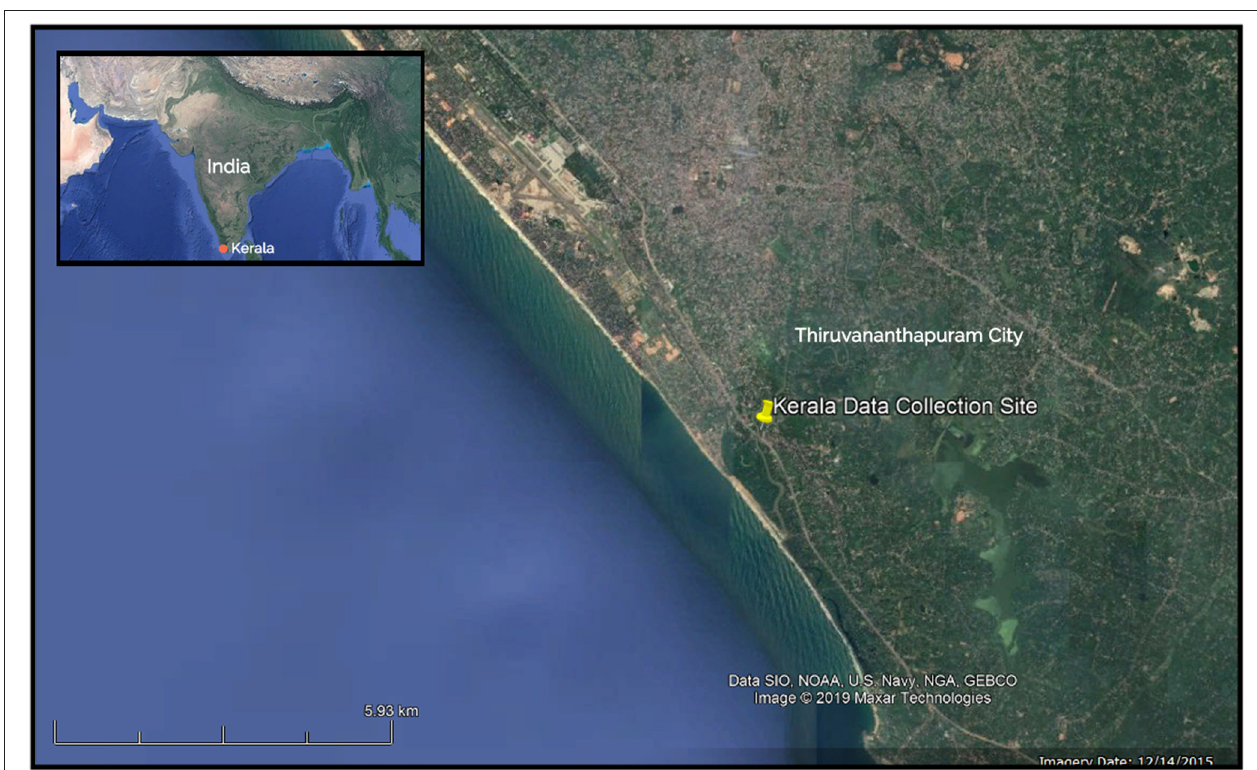
FIGURE 5 | Map of Indian site (Map by P. Kamil).